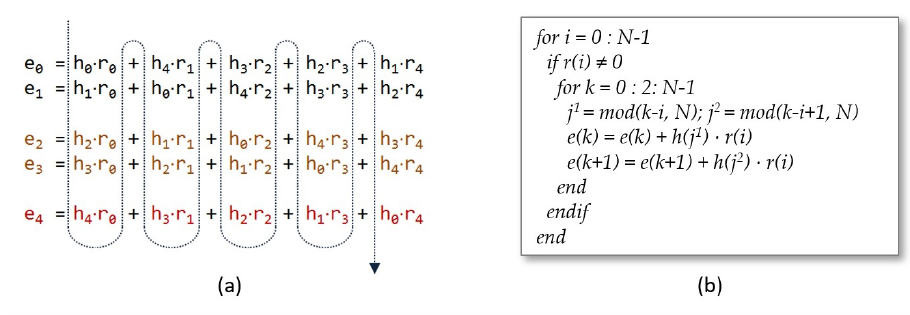
Figure 4. Simultaneous evaluation of two terms of the summation ( a ) and generation of indices i , j , and k ( b ) when the convolution matrix is swept by columns (colors indicate the terms evaluated in parallel).